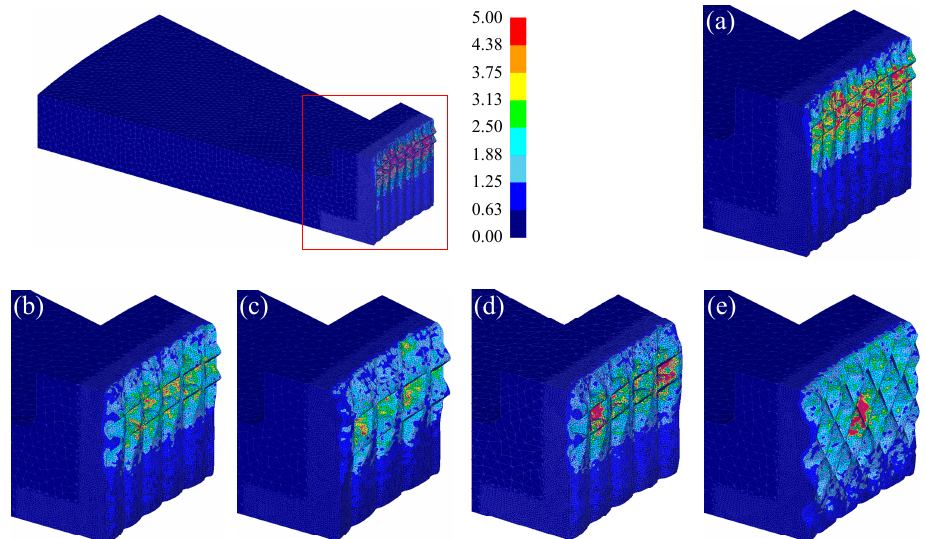
Figure 8. Distribution of effective strain: ( a ) Case 1; ( b ) Case 2; ( c ) Case 3; ( d ) Case 4; ( e ) Case 5.